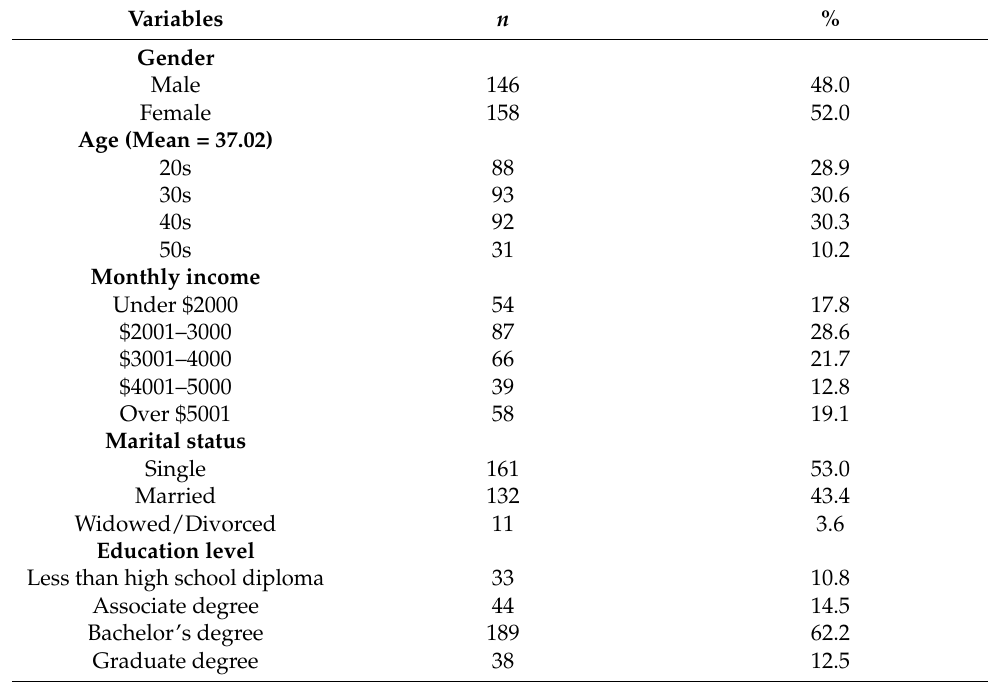
Table 1. Profile of respondents ( n =